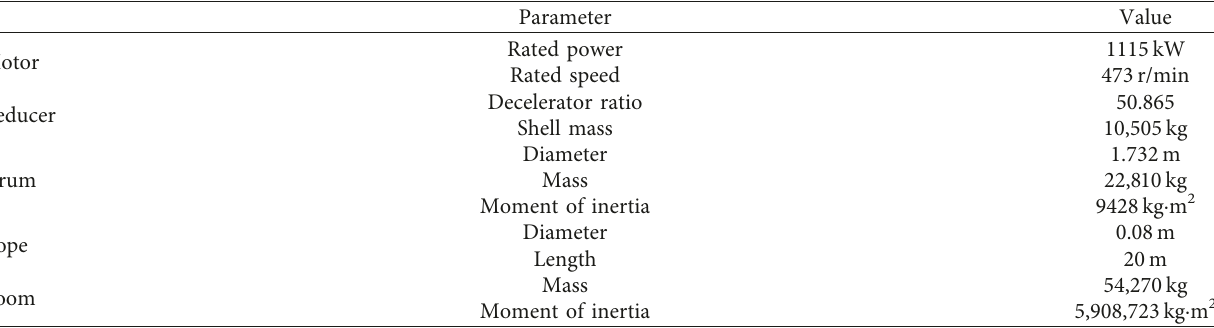
Table 1: Technical parameters of hoist system in EMS.